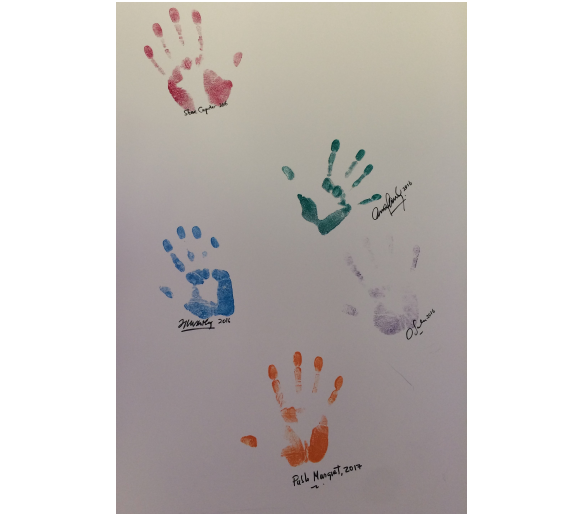
Fig. 4. Board members rotating out leave their handprints on the